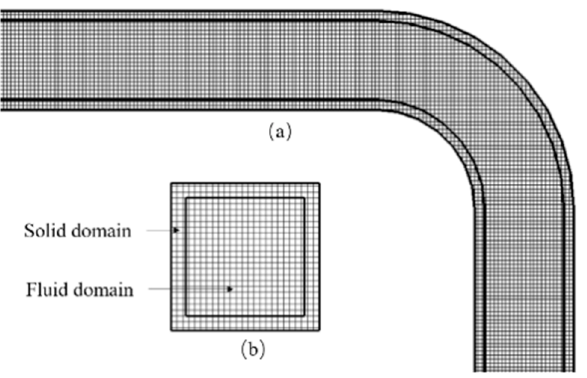
Figure 5. Mesh used for CHT simulation. ( a ) lateral view, ( b ) upstream view at cross section.